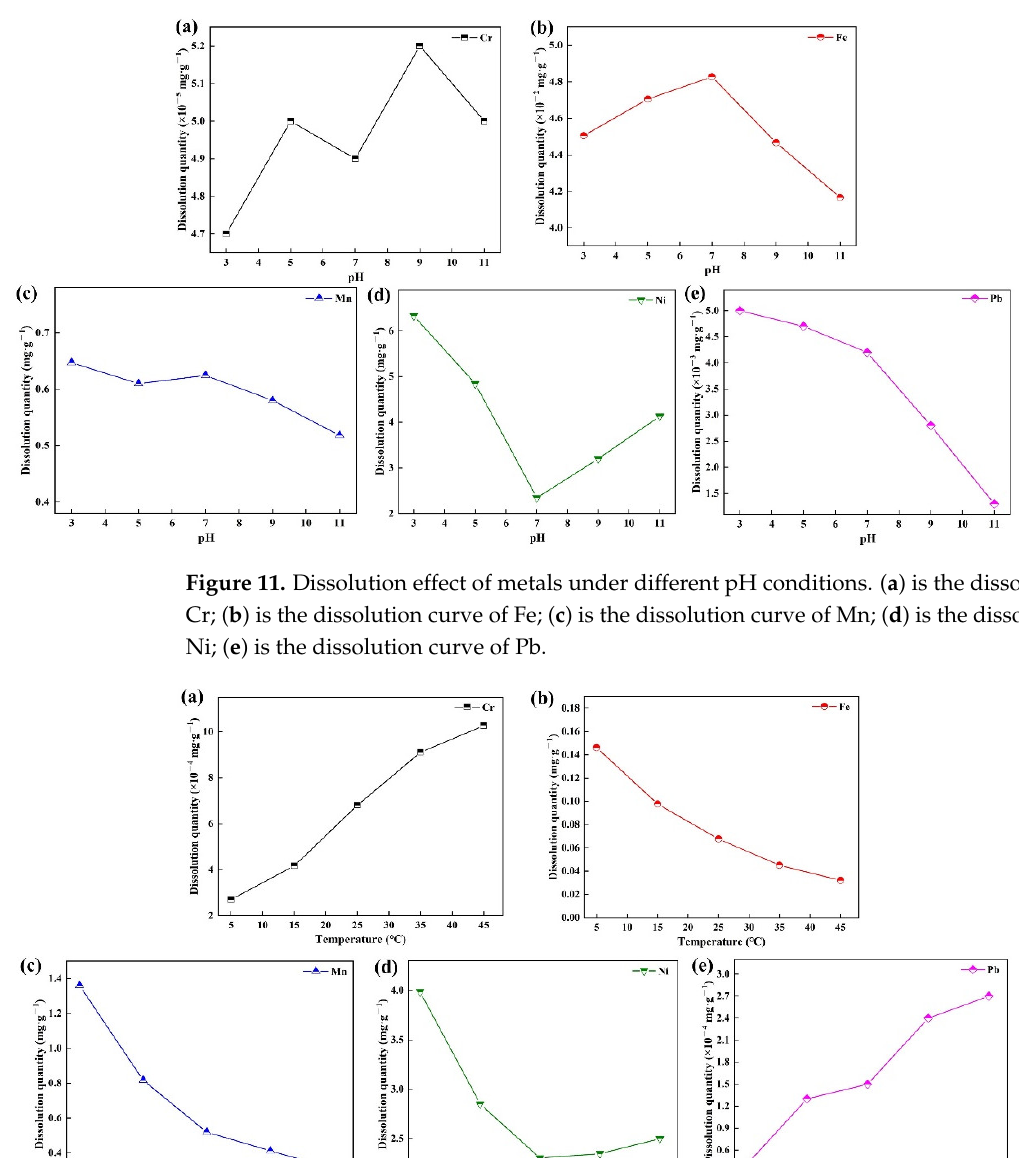
Figure 12. Dissolution effect of metals at different temperatures. ( a ) is the dissolution curve of Cr; ( b ) is the dissolution curve of Fe; ( c ) is the dissolution curve of Mn; ( d ) is the dissolution curve of Ni; ( e ) is the dissolution curve of Pb.